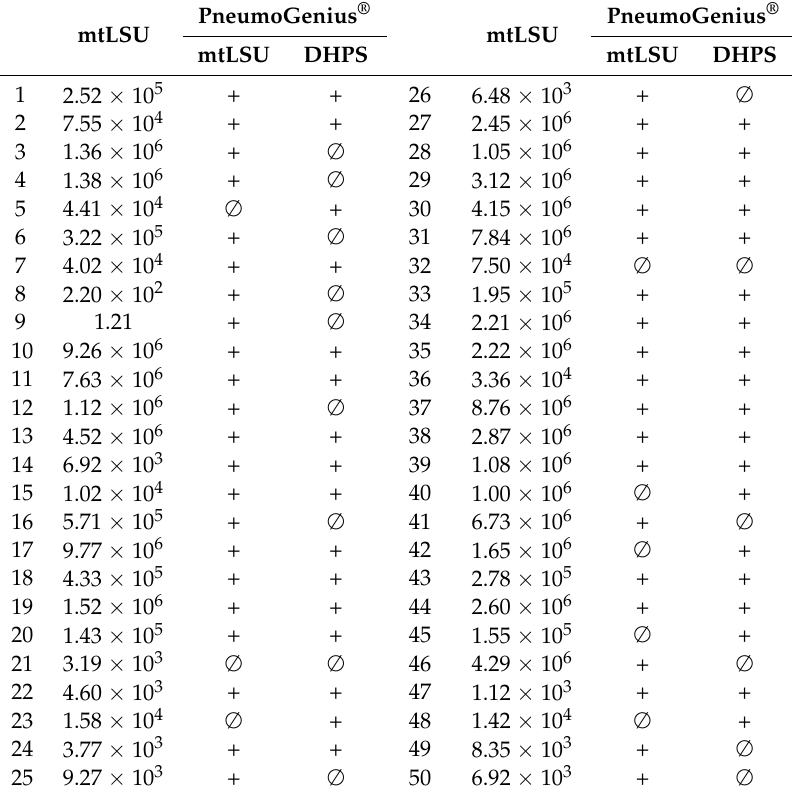
Table 1. Results of the PneumoGenius ® assay and the mtLSU PCR according to Botterell [14]. “+” positive tested, “ ∅ ” negative